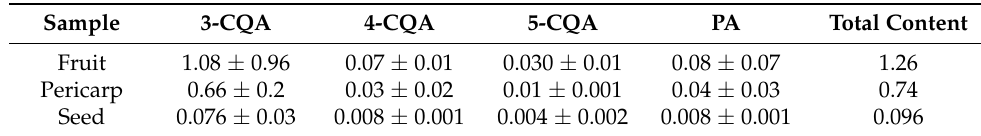
Table 1. Contents of phenolic acids (mg/g extract ± SD), n = 3 (3-CQA—chlorogenic acid, 4-CQA— cryptochlorogenic acid, 5-CQA—neochlorogenic acid, PA—protocatechuic acid. Additional informa- tion on HPLC–DAD data is given in the supporting information part).